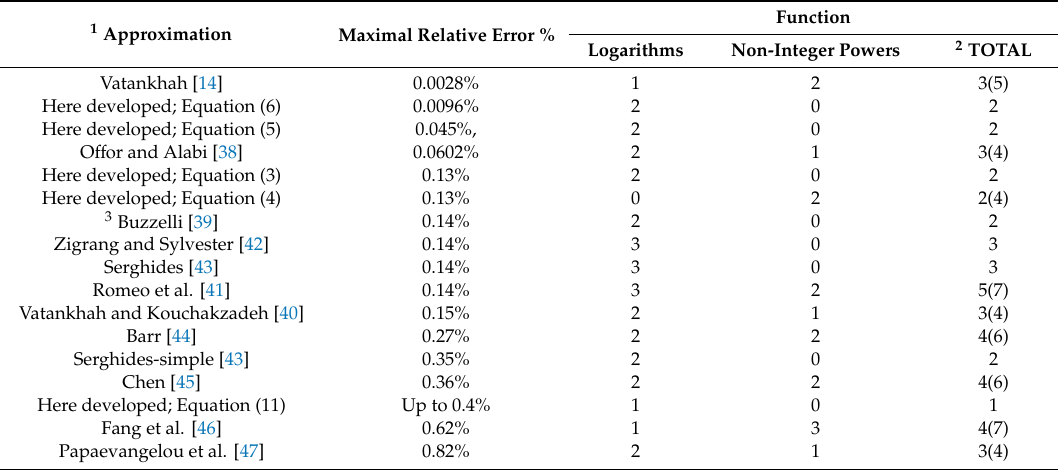
Table 2. Number of computationally expensive functions in the available approximations of the Colebrook equations that introduce a relative error of no more than